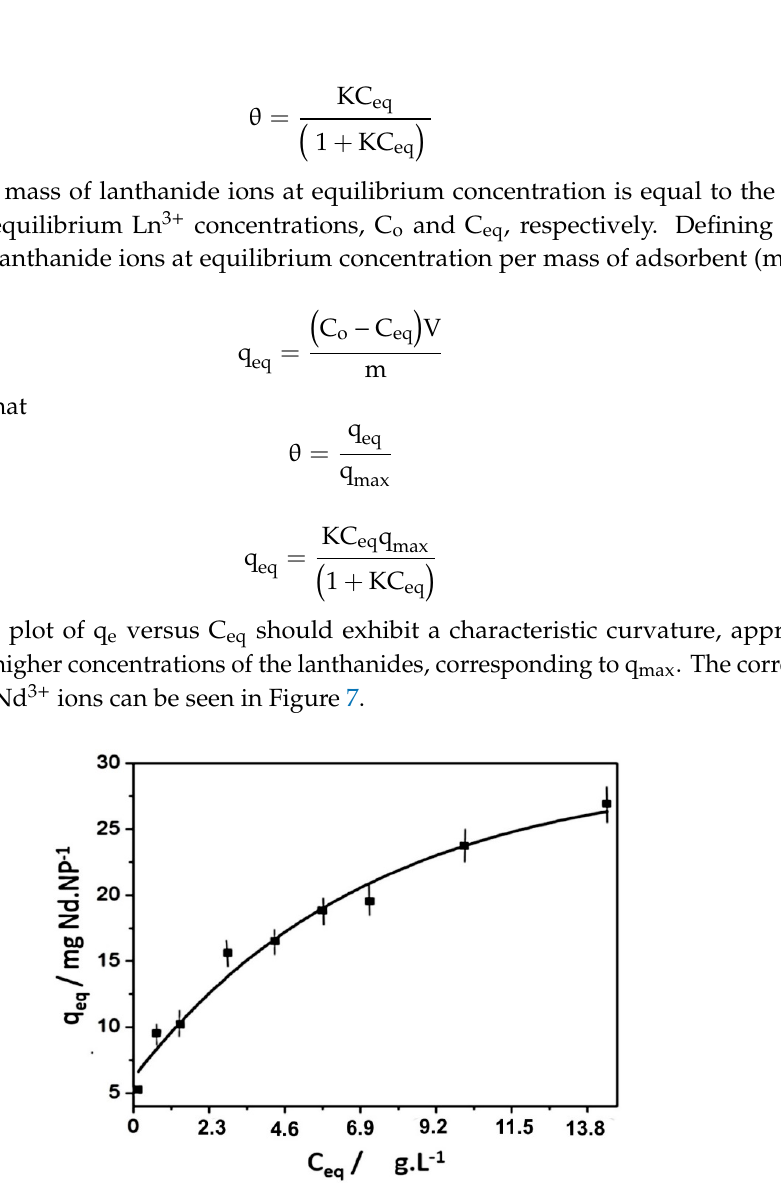
Figure 7. Adsorption isotherm of NP@DTPA in Nd 3+ solutions at 298 K (adapted with permission from [29]).